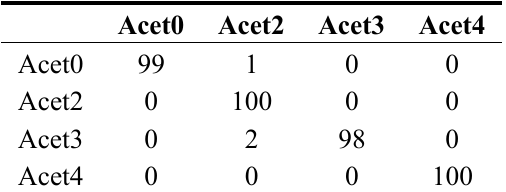
Table 4. Confusion matrix, calculated with the 50 simulations generated applying 10 rounds of 5-fold cross-validation over the 40 prototypes.